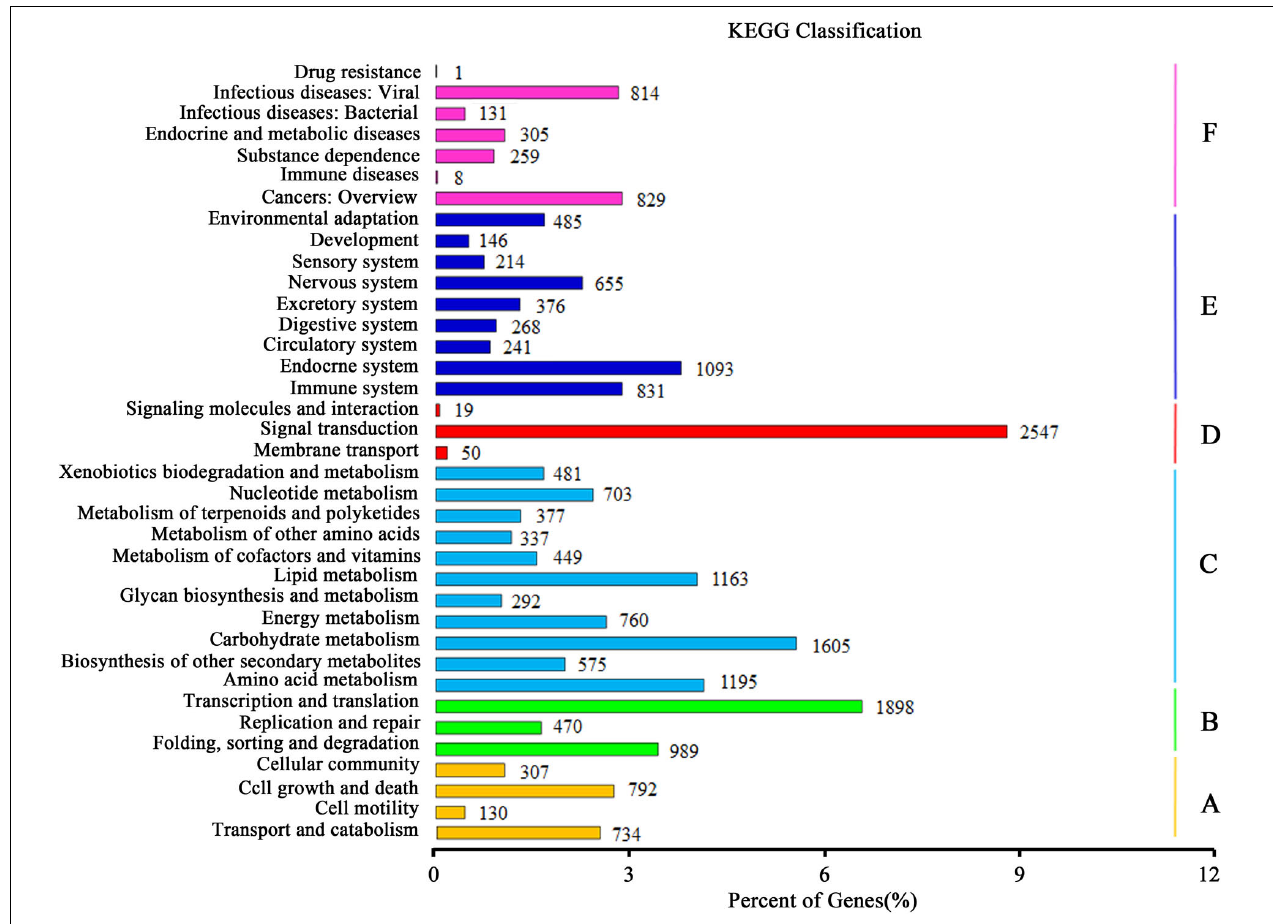
FIGURE 6 | Kyoto encyclopedia of genes and genomes (KEGG) classification of unigenes. (A) Cellular Processes; (B) Genetic Information Processing; (C) Metabolism; (D) Environmental Information Processing; (E) Organismal Systems; (F) Human